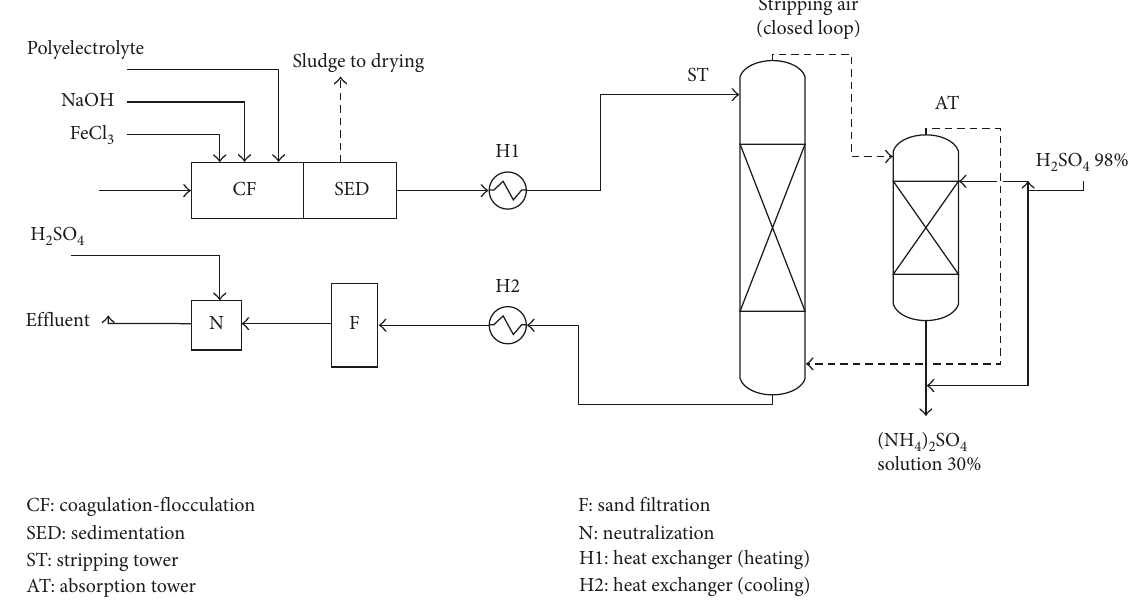
Figure 2: Schematic ammonia stripping process for leachate-polluted groundwater